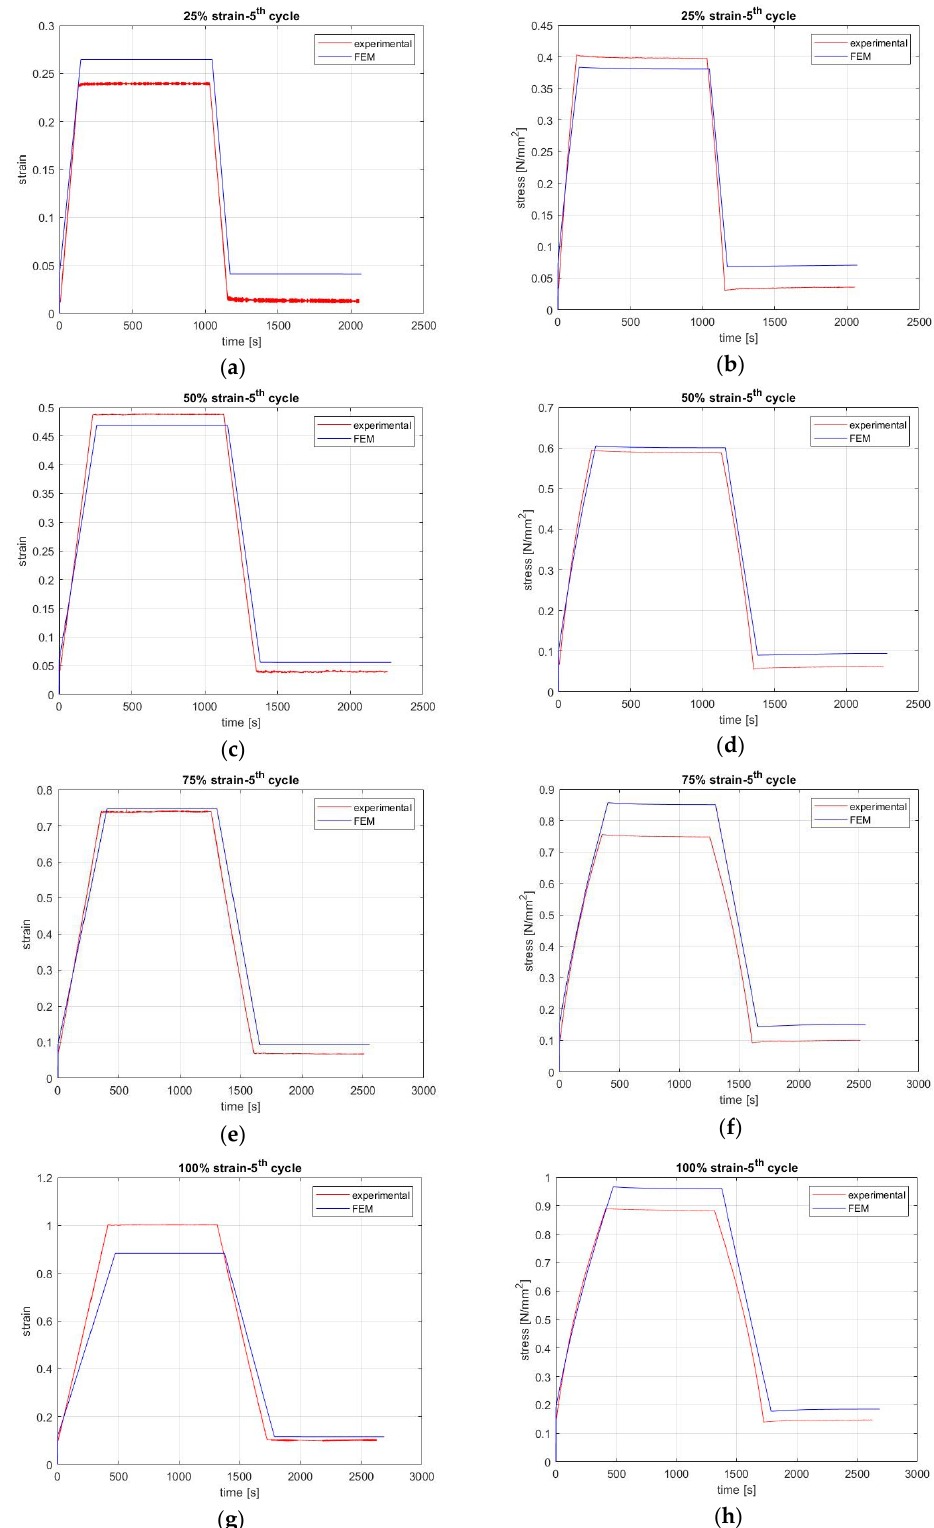
Figure 5. FEM compared with experimental results for the fifth cycle. Graphs in the left column show the history of applying ( a ) 25%, ( c ) 50%, ( e ) 75%, and ( g ) 100% strain and partially removing it until it reaches 10% of the applied strain (cause). Graphs in the right column show the stress response following the application and removal of ( b ) 25%, ( d ) 50%, ( f ) 75%, and ( h ) 100% strain as a step function (effect).